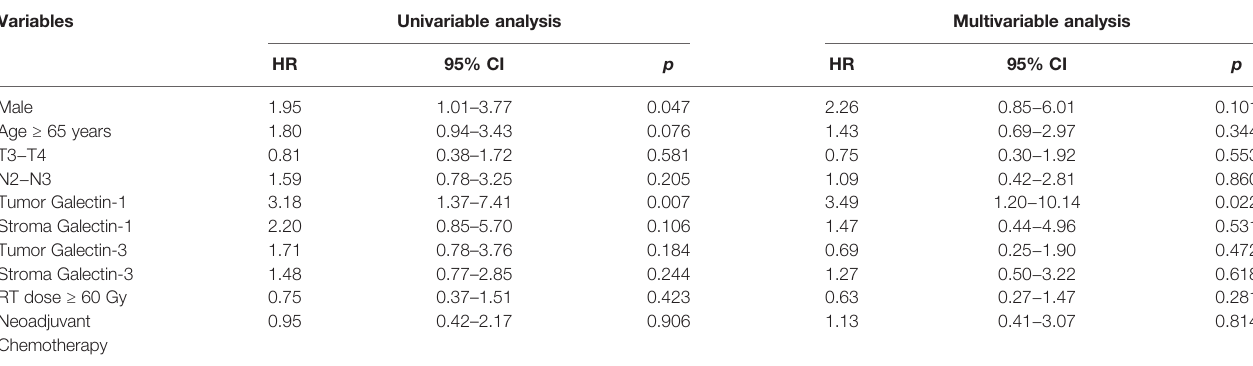
TABLE 3 | Univariable and multivariable Cox regression analyses of LRPFS. Variables Univariable analysis